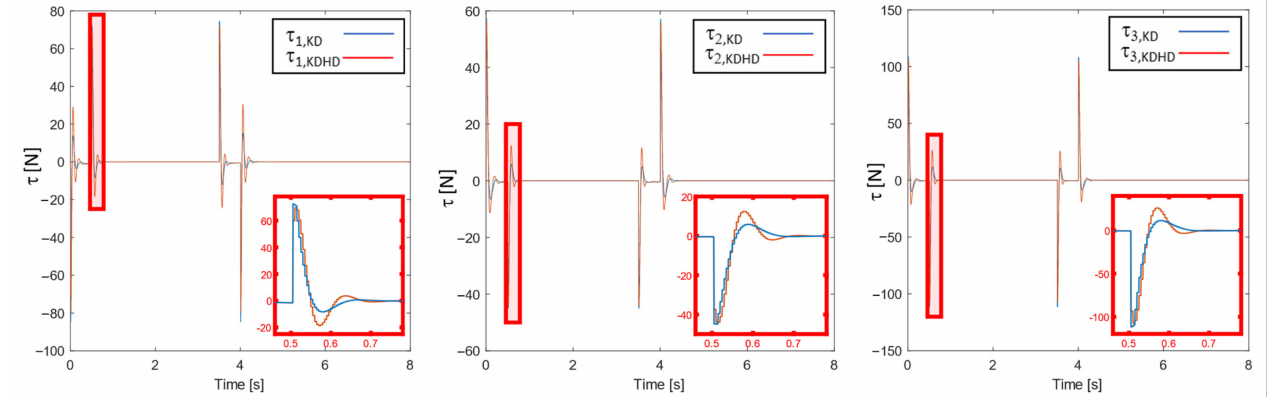
Figure 7. Case study A, k KD = k KDHD = 1 · 10 4 N/m, KD-KDHD comparison number I, ramp time t ramp = 0.5 s, stop time t stop = 3 s, actuation